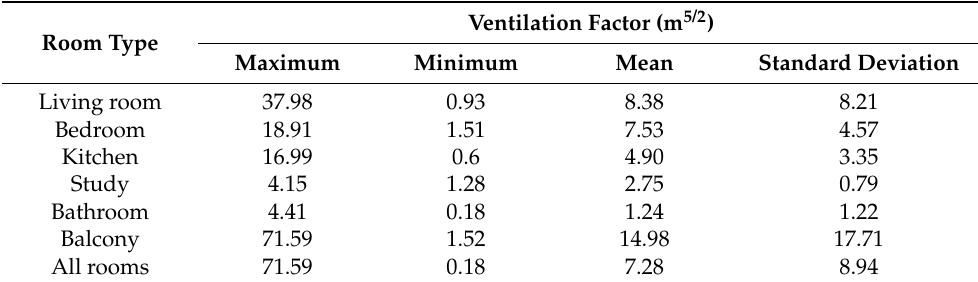
Figure 5. Ventilation opening of the living room. Table 3. Statistics of ventilation factor for different types of rooms.